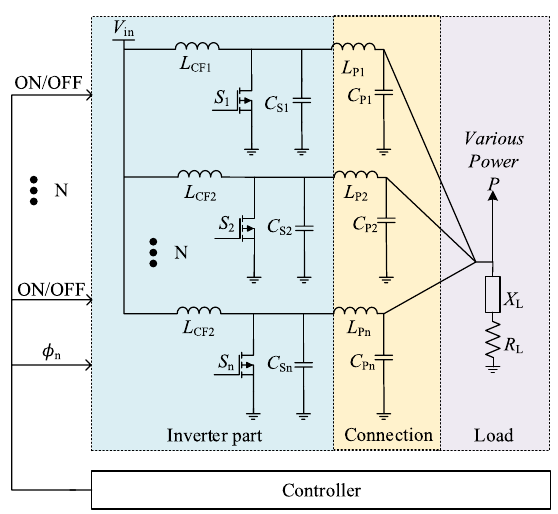
Fig. 1 Inverter system structure